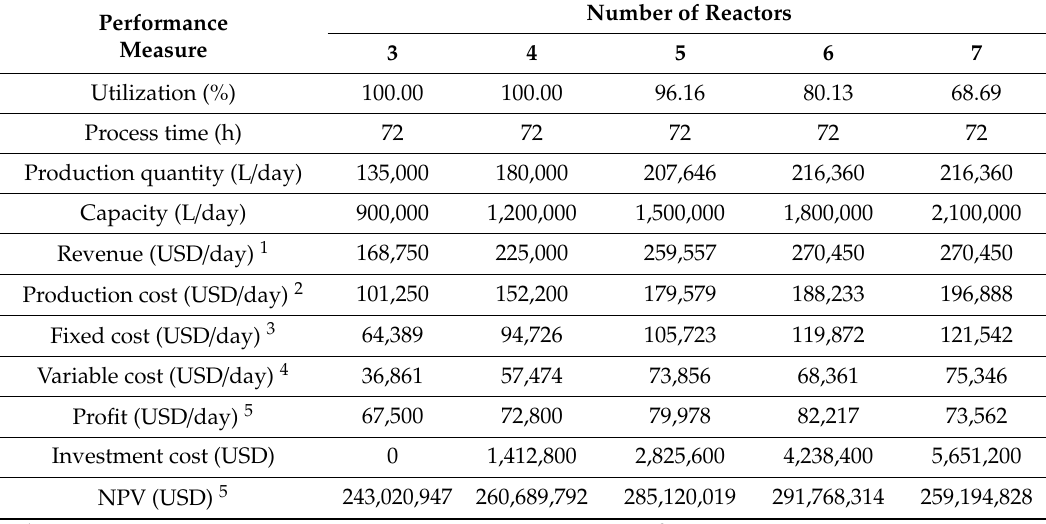
Table 4. Performance of reactors at a refinery.